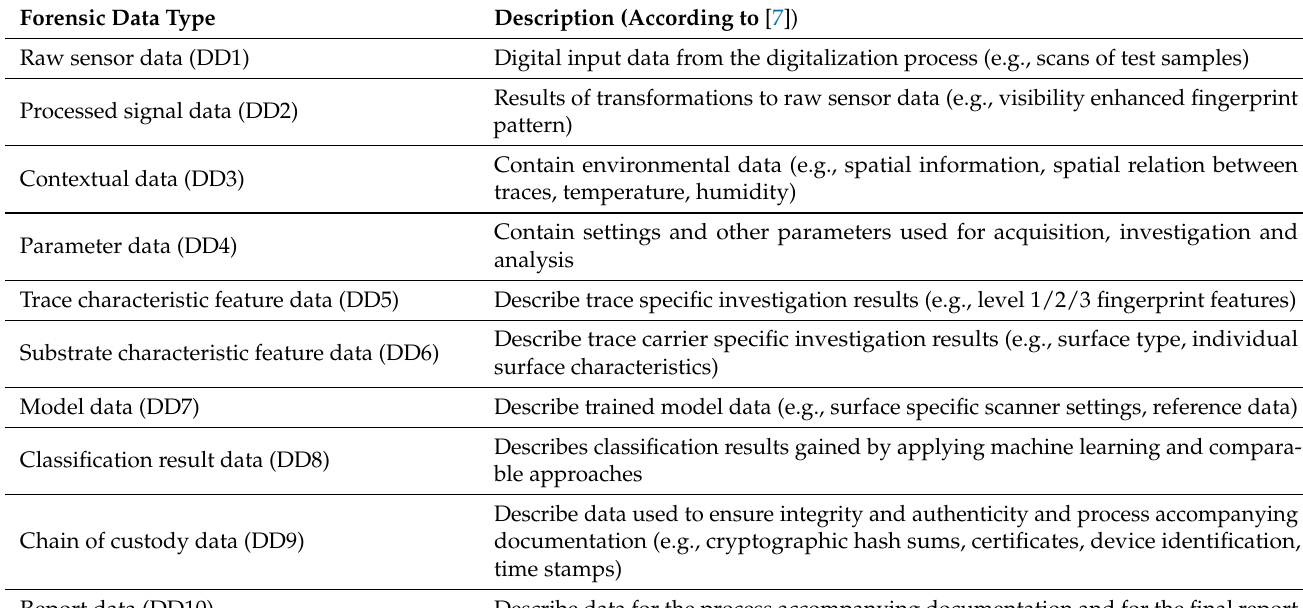
Table 3. Forensic data types defined in [7] for an exemplary selected process in digitized forensics (here, digital dactyloscopy) (updated from